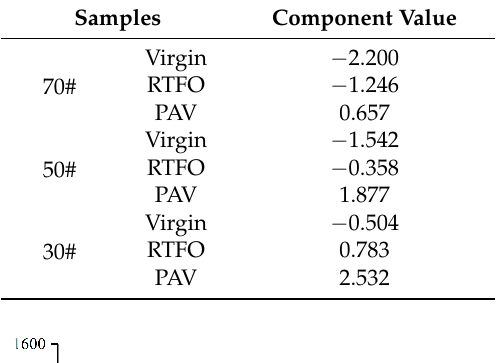
Table 7. Principal components of the chemical functional groups of the bitumen.